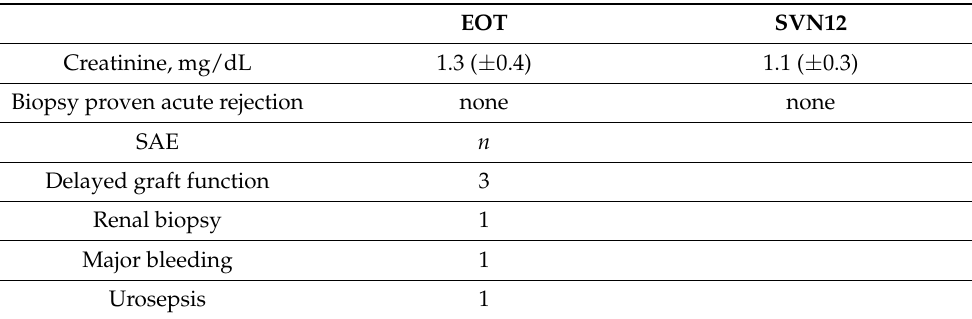
Table 3. Baseline characteristics of HCV positive donors and of HCV negative recipients.